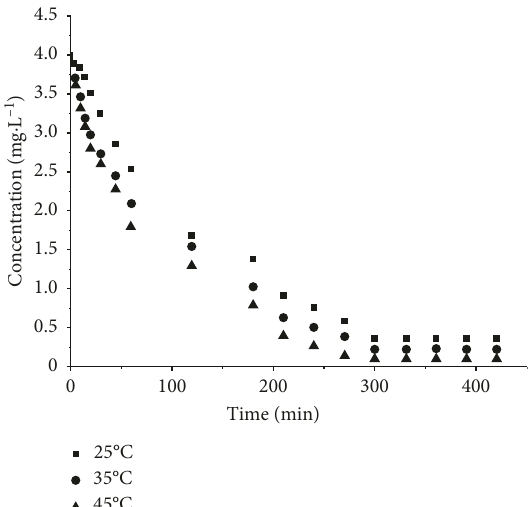
Figure 4: Concentration of fluoride ions as a function of time using mesocarp as